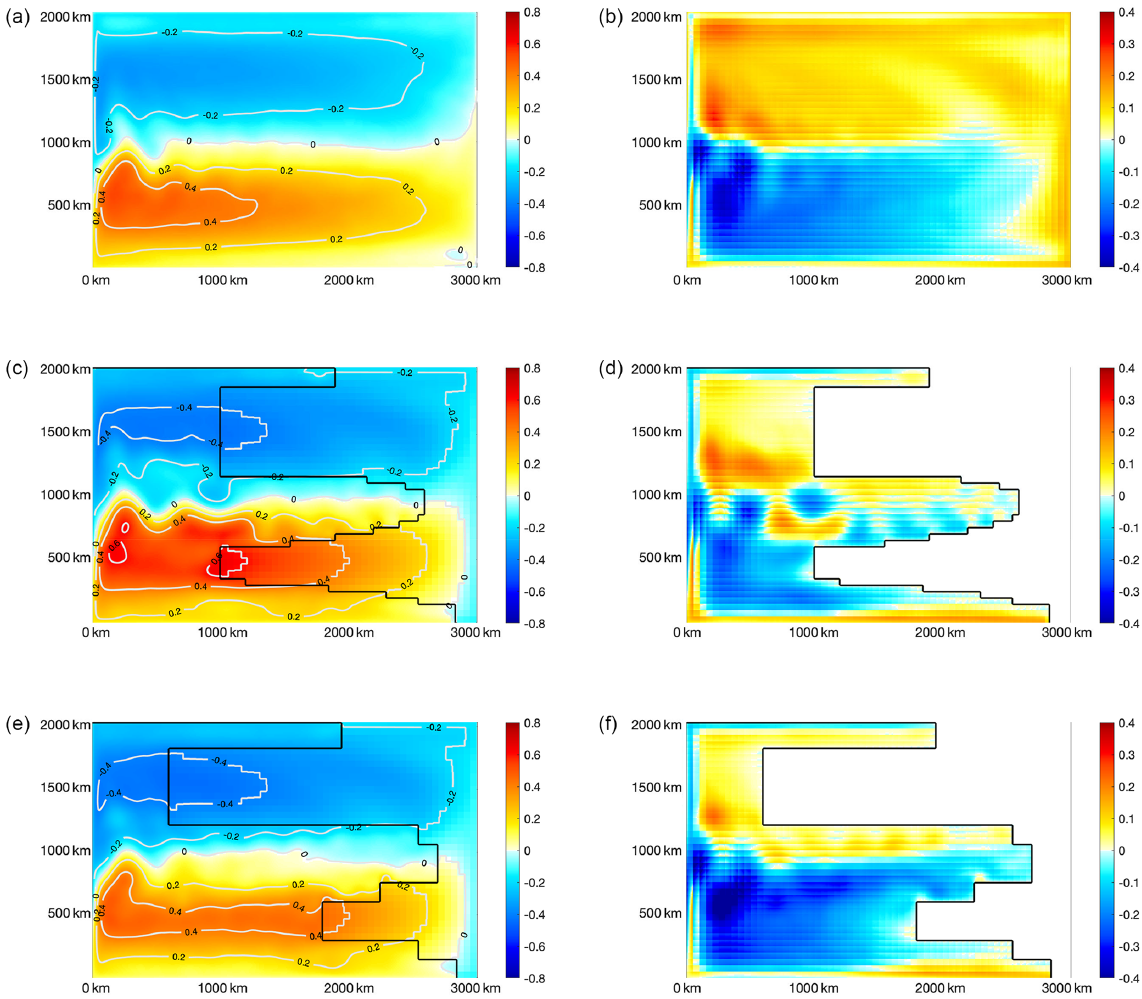
Figure 8. SSH climatology (a, c, e) of the full-field M experiment (a, b) and two regionally refined 0.5–0.1 ◦ experiments (L-M-I and L-M-II in c , d and e , f ). Difference with 0.5 ◦ simulations is shown in (b) , (d) , and (f) , respectively.